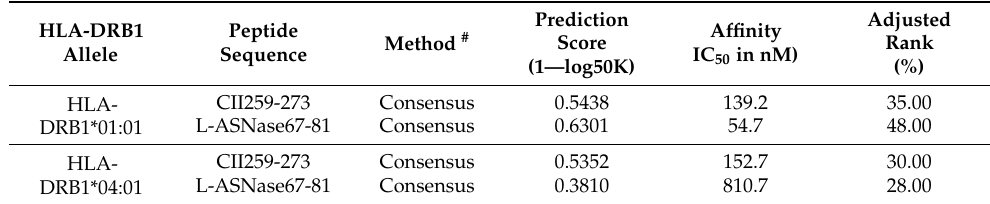
Table 1. Binding properties of the peptides CII259-273 and L-ASNase67-81 to the RA-associated HLA-DRB1